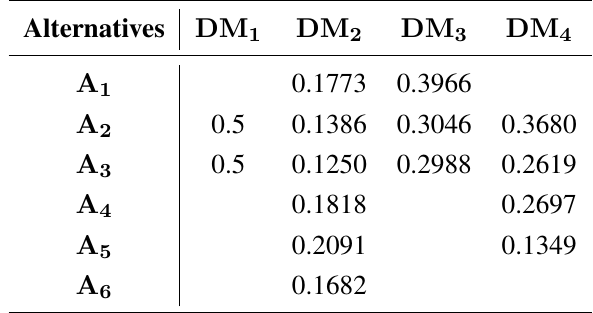
Table 11. Score matrix of the alternatives for each expert.